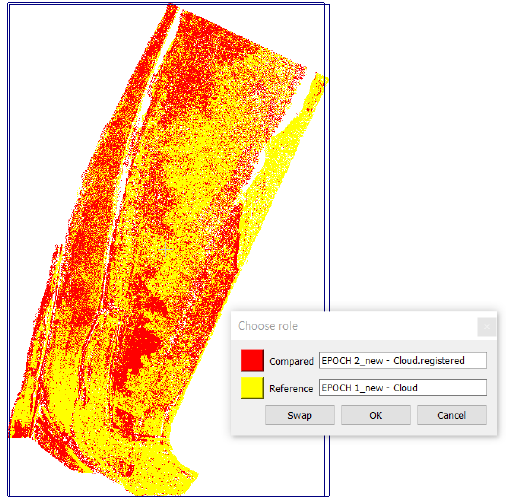
Figure 17. The selection of datasets to be used in the C2C distance computation process